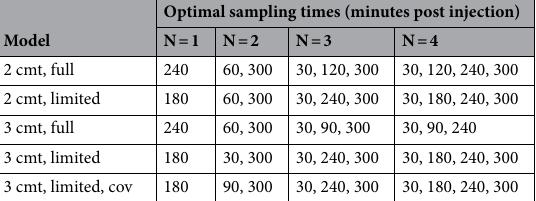
Optimal sampling times (minutes post Model